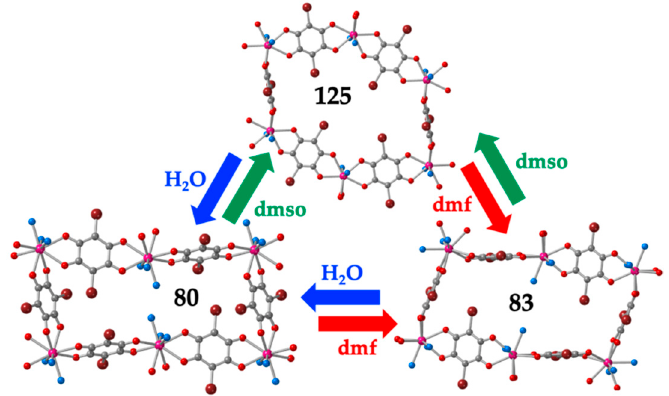
Figure 26. Solvent exchange scheme between compounds [Dy 2 (C 6 O 4 Br 2 ) 3 (H 2 O) 6 ] ∙ 8H 2 O ( 80 ),